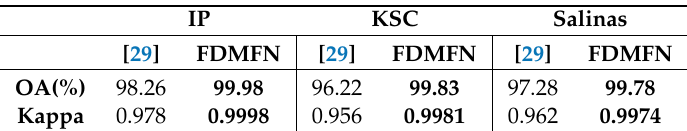
Table 14. Comparison between the proposed FDMFN and the 2D spectrum based CNN model [29] on the IP, KSC, and Salinas datasets. Note that the best results reported in [29] were used for comparison here. In addition, the best results are highlighted in bold font.